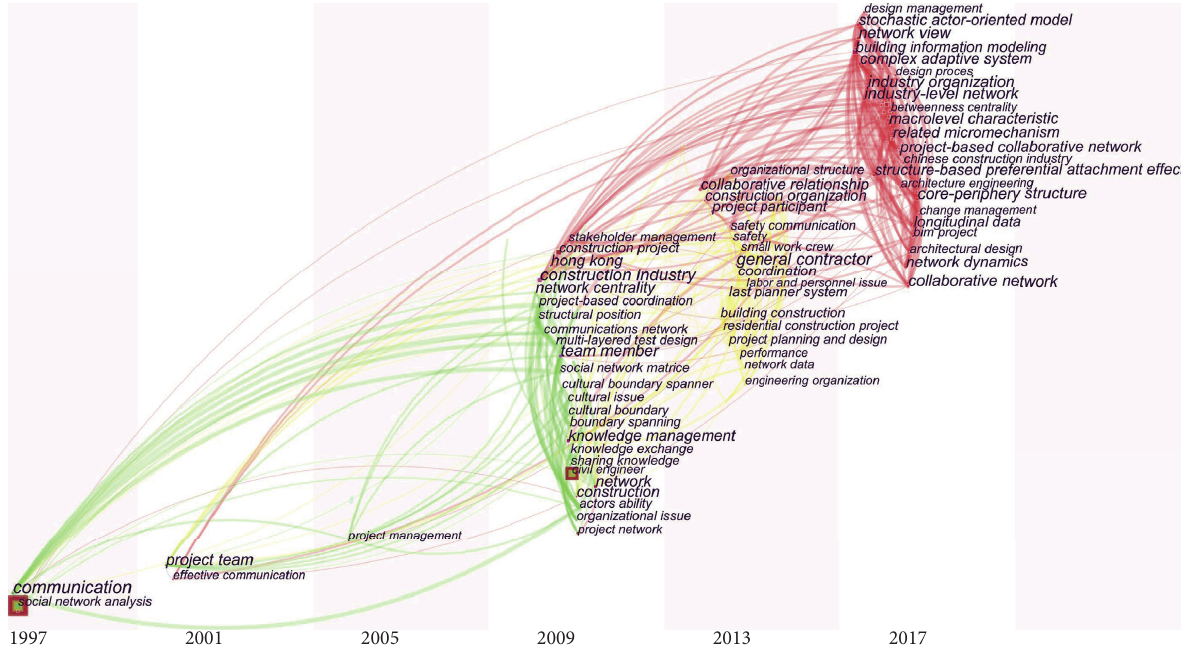
Figure 4: The timeline map of keyword cooccurrence network